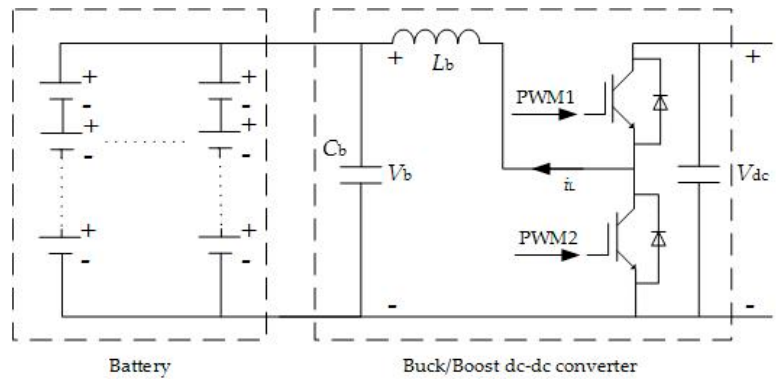
Figure 4. The energy storage module of the RBE feedback system.